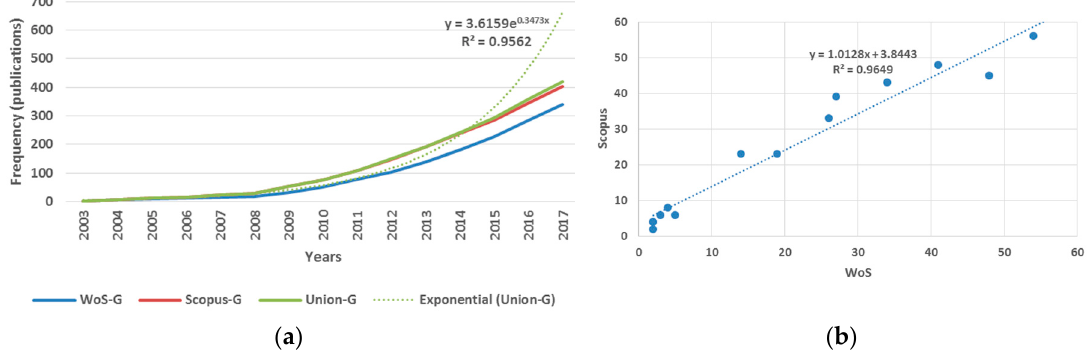
Figure 3. Growth ( a ) and Correlation (publications) ( b ). Source: Own elaboration.